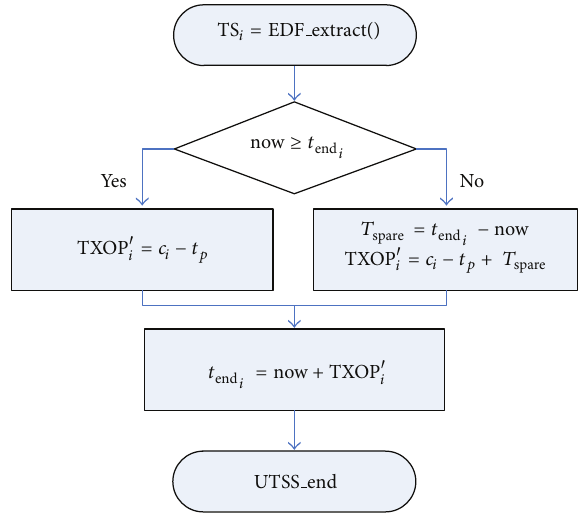
Figure 3: UTSS mechanism integrated with the centralized sched-